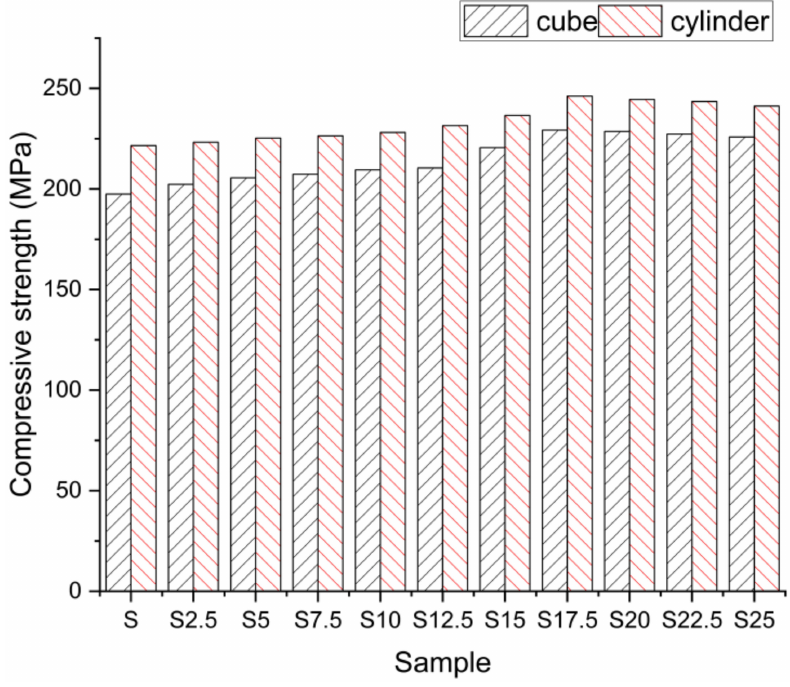
Figure 7. Compressive